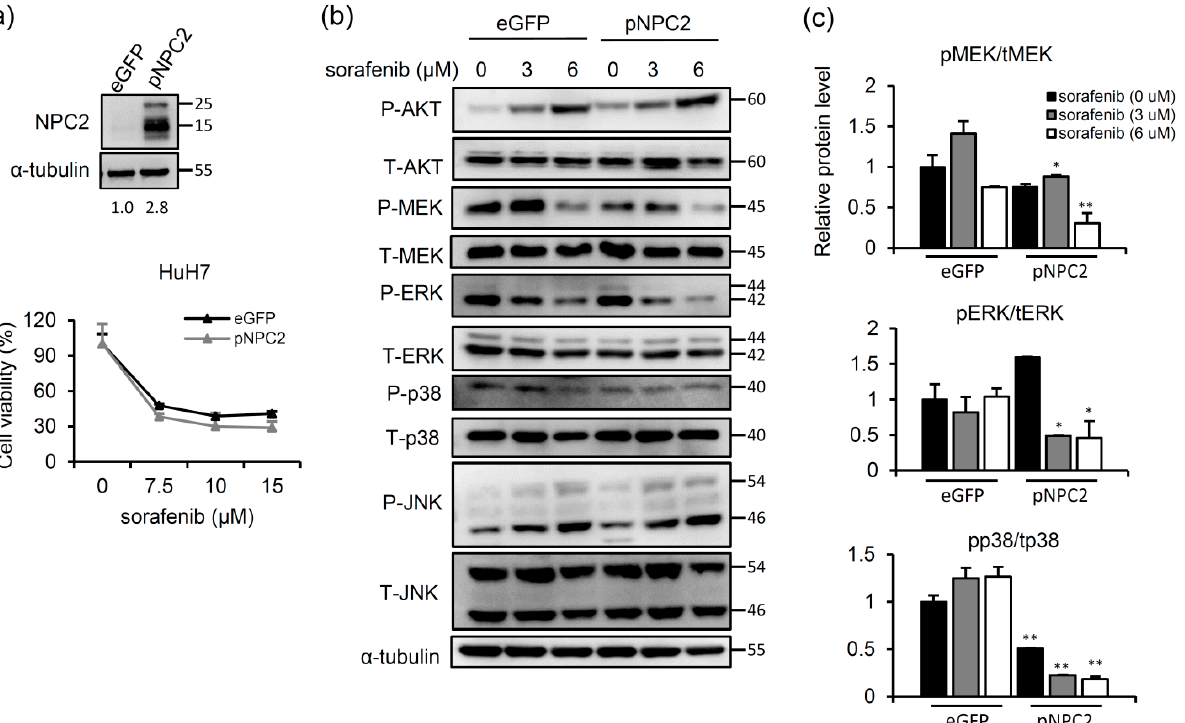
Figure 3. Niemann-Pick type C2 (NPC2) overexpression inhibits mitogen-activated protein kinase (MAPK)/extracellular signal-regulated kinase (ERK) signaling and slightly affects sorafenib-induced cytotoxicity. ( a ) A western blot analysis was used to confirm the effect of NPC2 overexpression. HuH7 cells were treated with sorafenib (0, 7.5, 10, and 15 µ M) for 48 h and then harvested for an MTT assay. ( b ) HuH7 cells were treated with 0, 3, and 6 µ M of sorafenib for 48 h, and protein expression levels of AKT, MAPK kinase (MEK), ERK, p38, and c-Jun N-terminal kinase (JNK) were detected by western blotting. α -tubulin was used as an internal control. These experiments were repeated three times with similar results. ( c ) Western blot images were quantified with Image J software. * p < 0.05, ** p < 0.01 compared to enhanced green fluorescent protein (eGFP) cells.